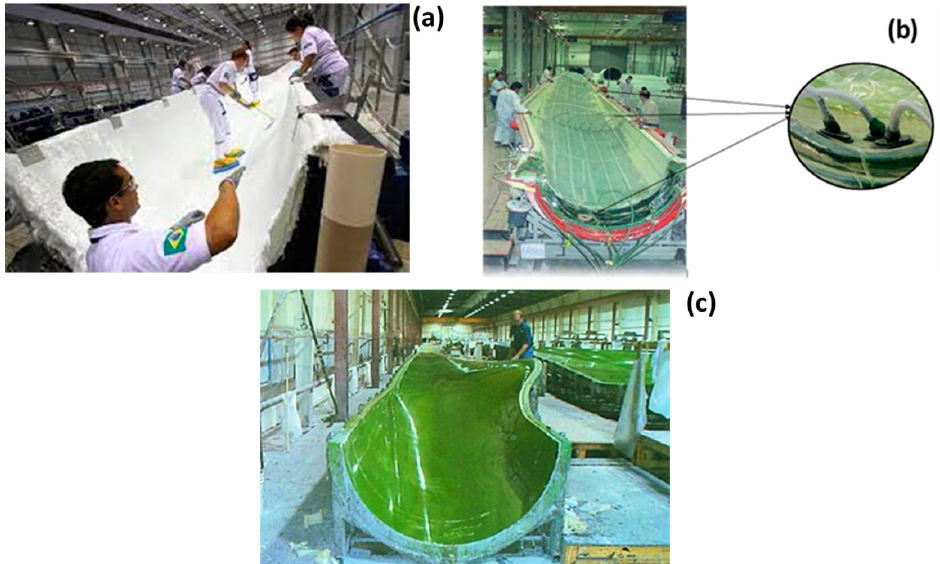
Figure 2. Wind turbine blade manufacturing process: ( a ) hand lay-up [28], ( b ) vacuum infusion or prepregging [29], ( c ) vacuum-assisted resin transfer moulding (VARTM) [30].